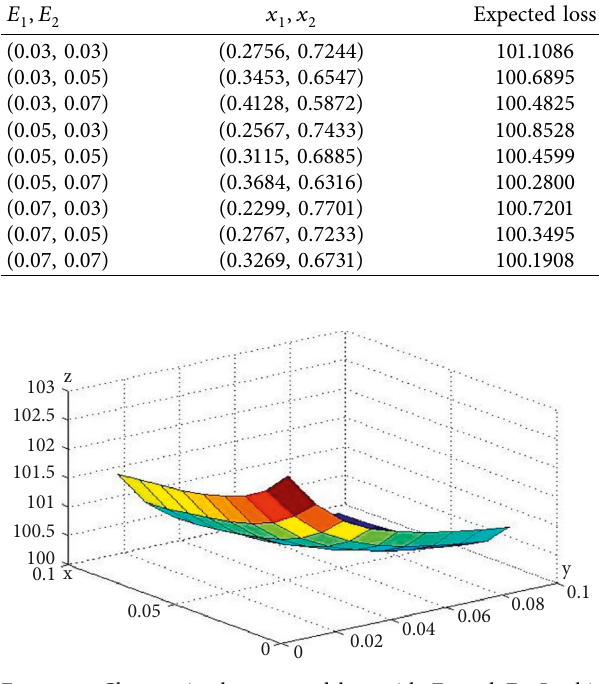
and E . In this 1 2 ), and z axis denotes the ex- 2